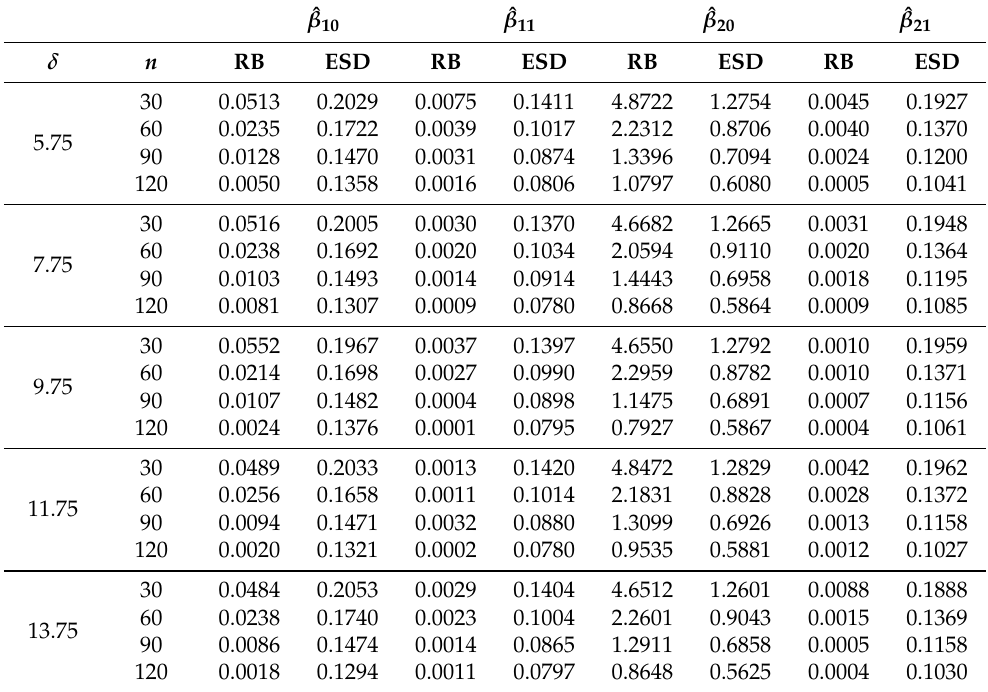
Table 2. RB and ESD for the BSHPN regression model.